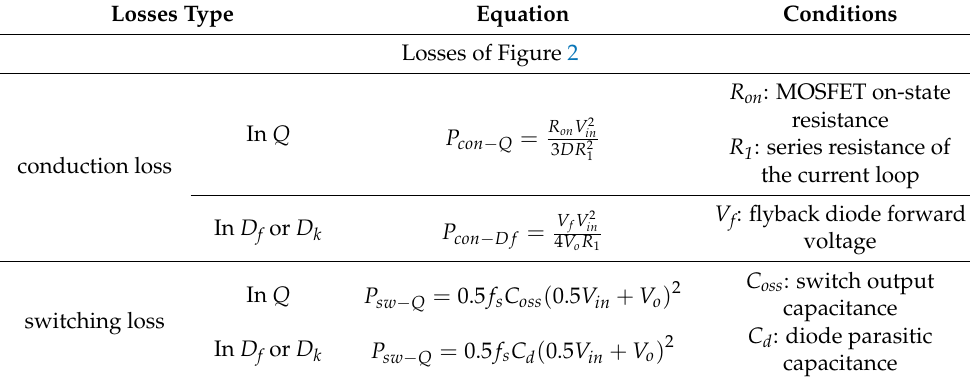
Table 2. Calculation of loss components [25–27].